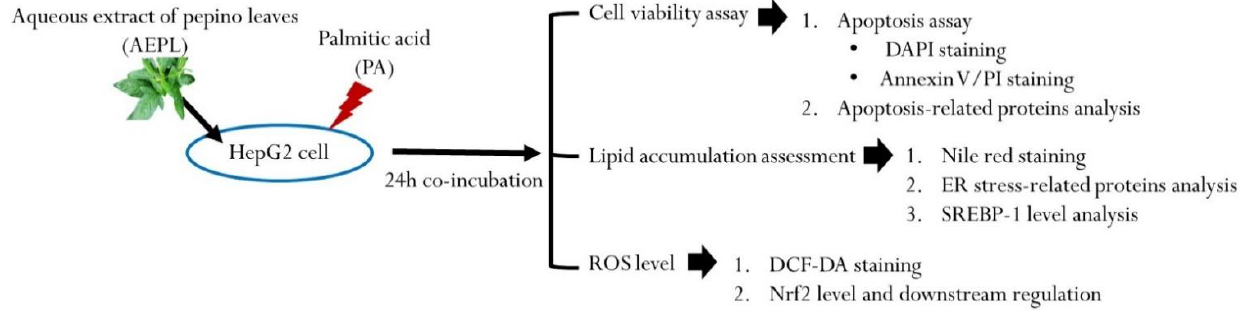
Figure 1. Scheme of experiment design.